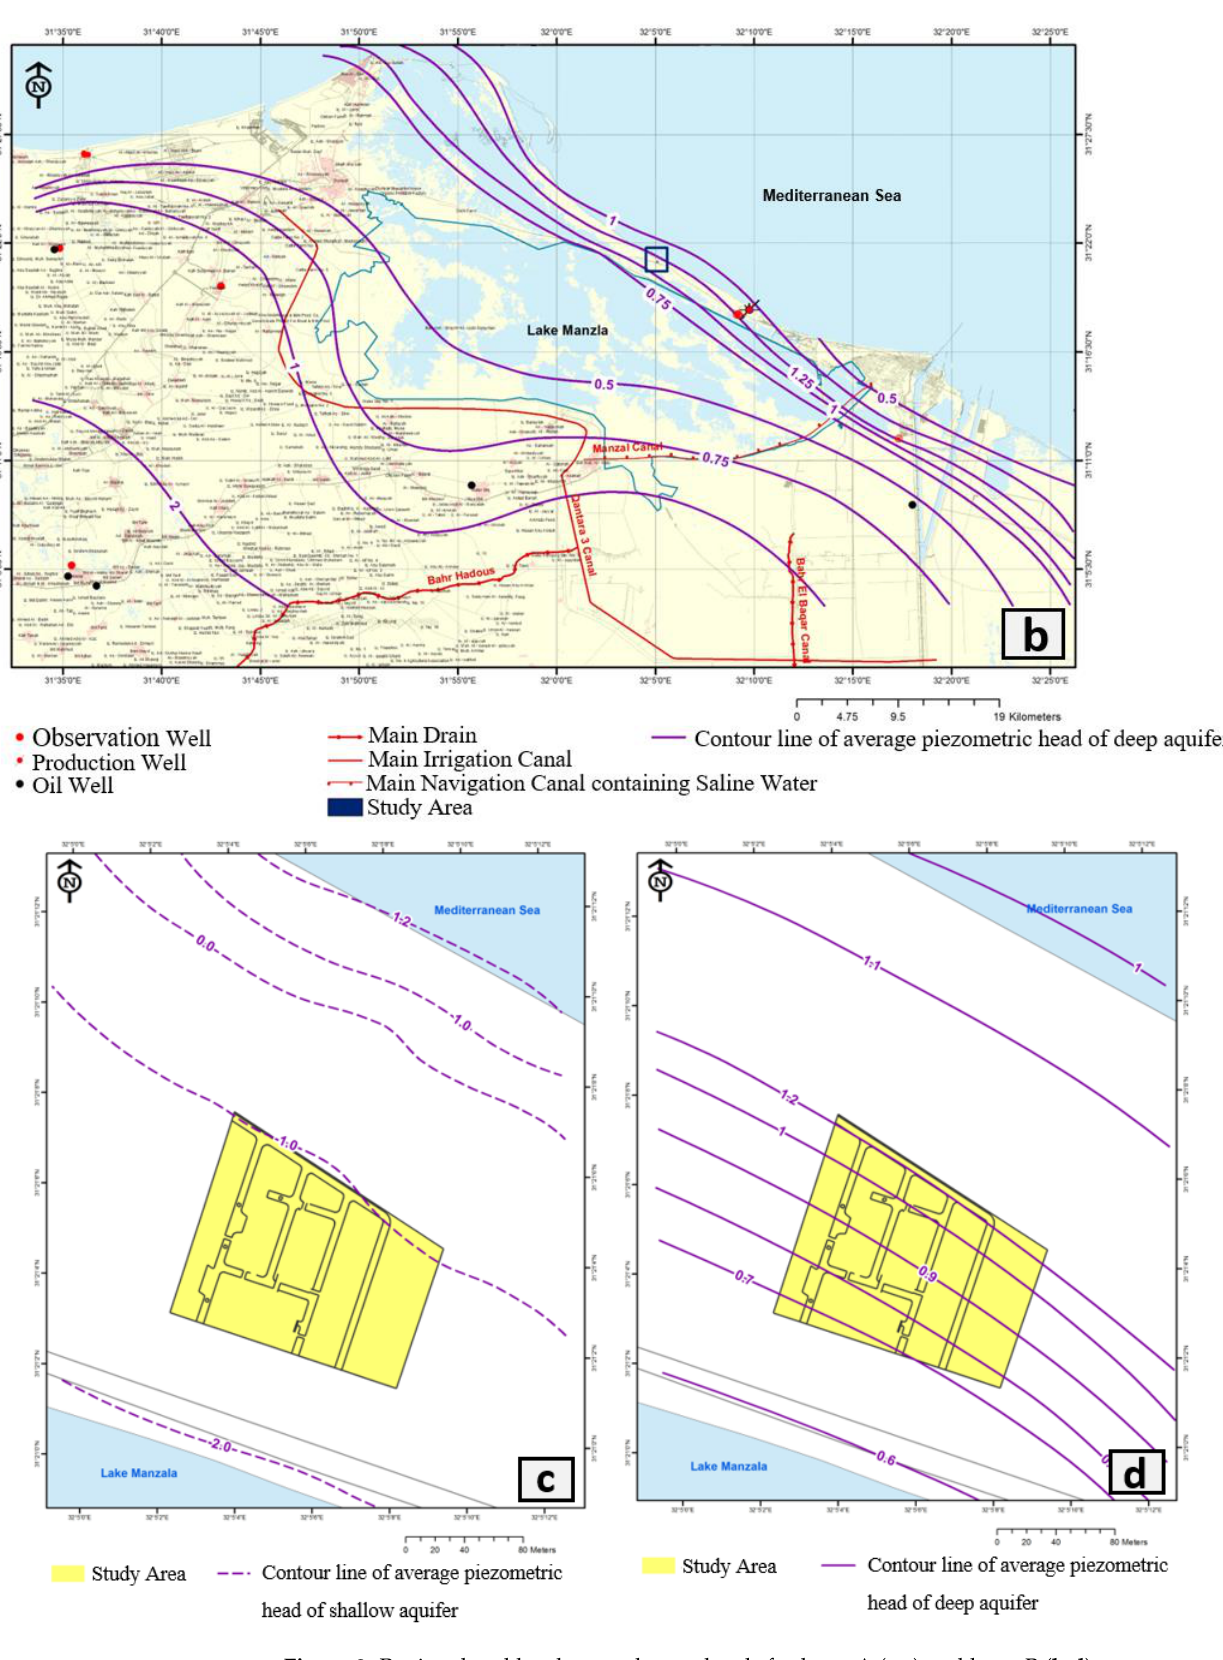
Figure 2. Regional and local groundwater levels for layer A ( a , c ) and layer B ( b , d ) .